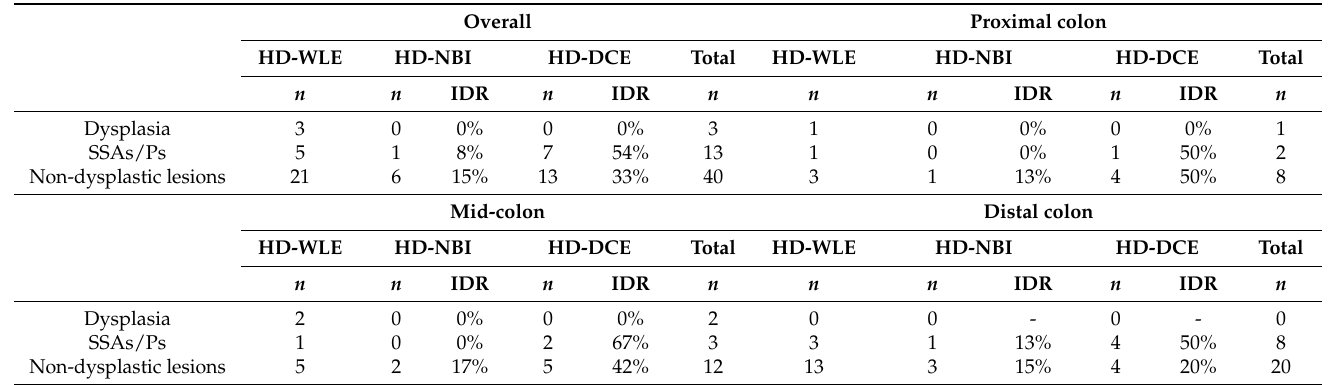
Table 2. Per-polyp analysis of dysplasia, sessile serrated adenoma/polyps, and non-dysplastic lesions detected by HD-WLE, HD-NBI, and HD-DCE.